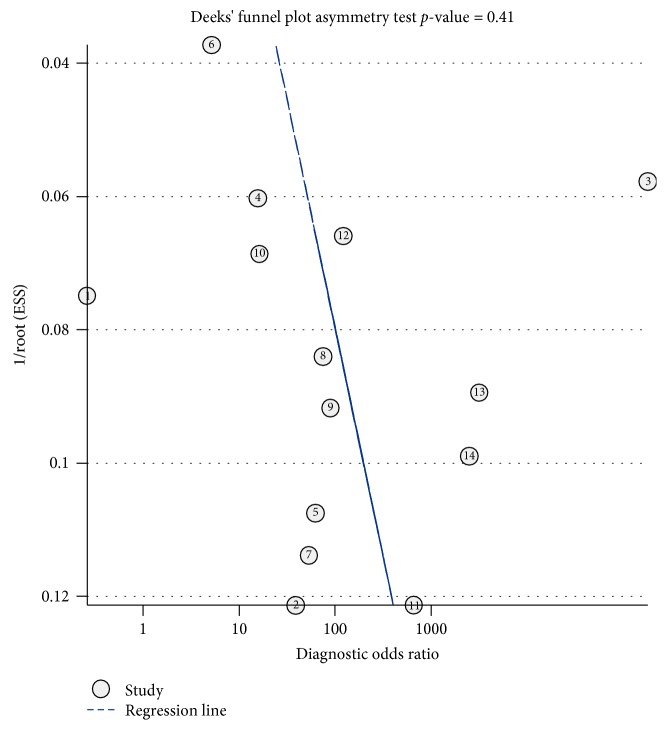
Deeks' funnel plot.